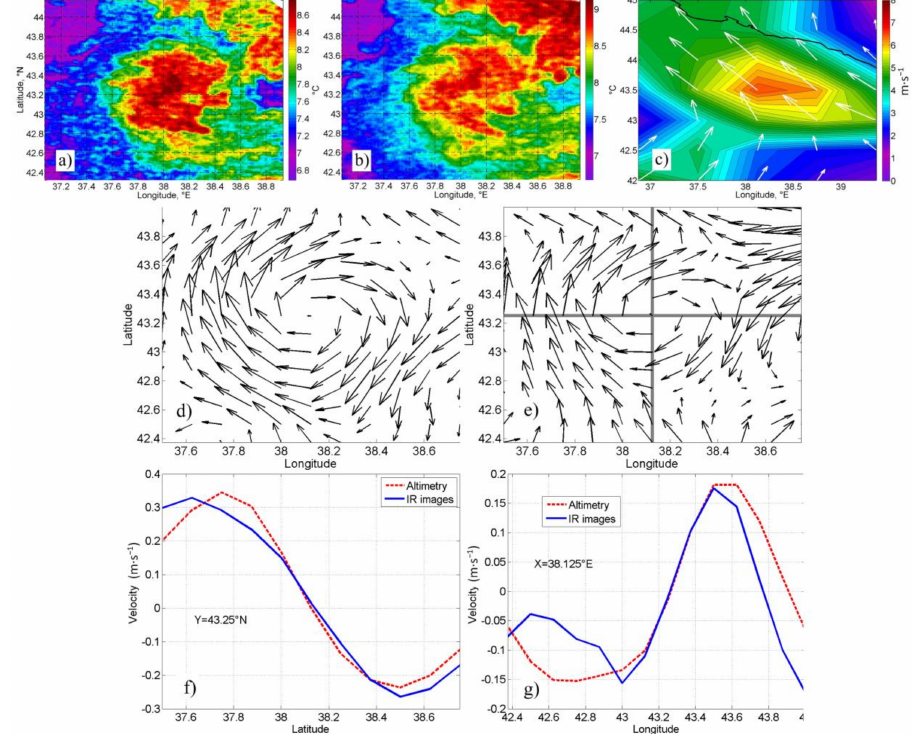
Figure 2. ( a , b ) AVHHR SST at 13 February 2007 23:15 ( a ); 14 February 2007 08:36 ( b ); ( c ) Wind velocity from Merra dataset at 14 February 2007 06:00; ( d , e ) Surface current calculated for 13 February 2007 from altimetry ( d ), from IR images (solid line—sections) ( e ); ( f , g ) meridional section of u ( f ), zonal section of v ( g ) (red—altimetry; blue—IR